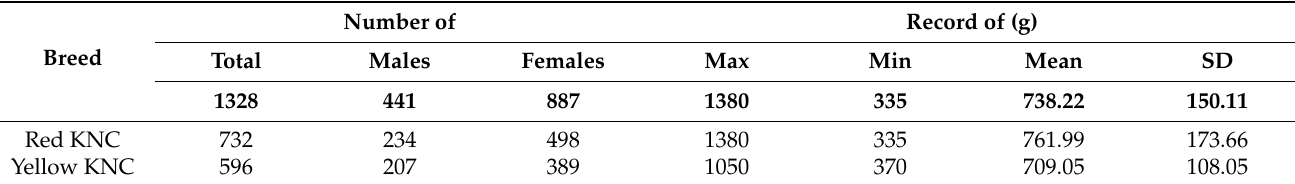
Table 1. Descriptive statistics for body weight in two Korean native chicken (KNC) populations at age 8 weeks. Breed